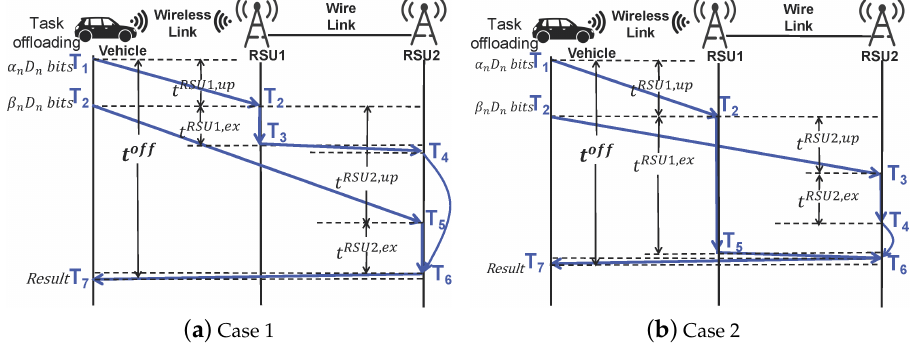
Figure 2. Delay analysis of two offloading